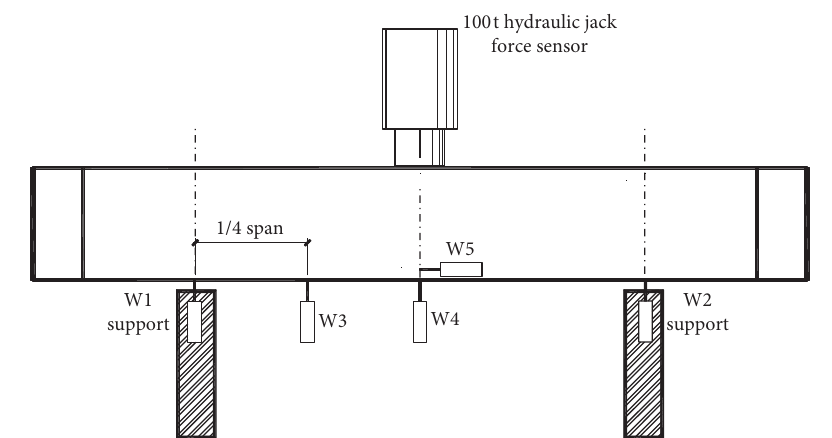
Figure 3: Displacement meter arrangement.